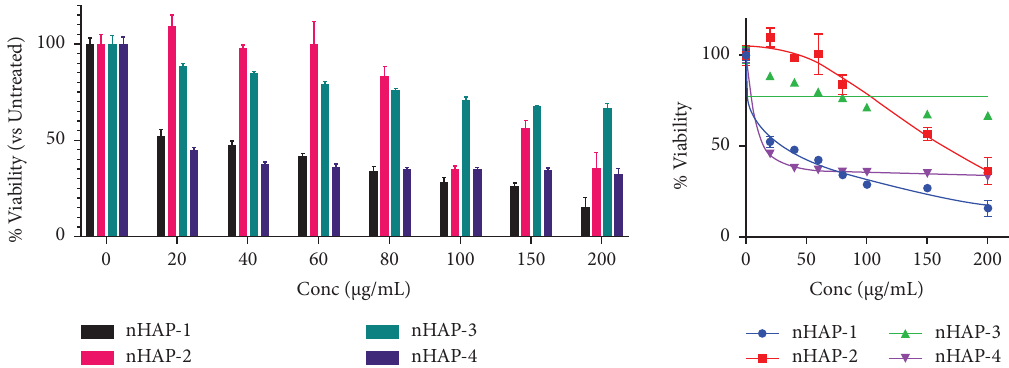
Figure 3: In vitro cytotoxicity of nHAP constructs in MCF-7 breast cancer cells.